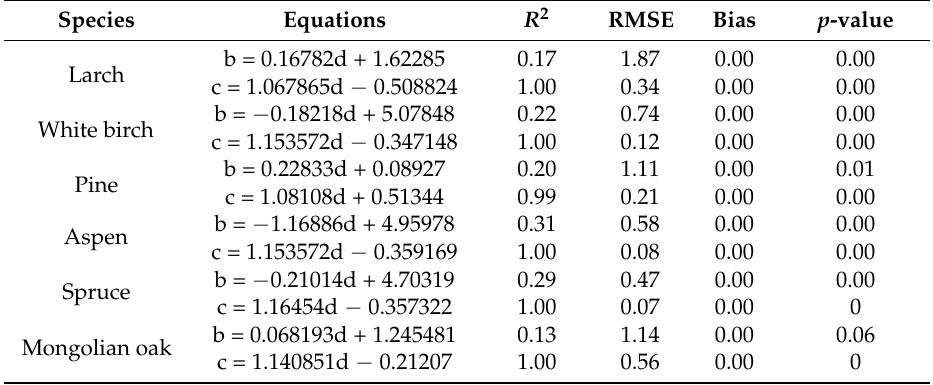
Table 3. Equations of shape parameter (b) and scale parameter (c) of Weibull diameter distribution depend on arithmetic mean DBH (d, unit: cm) for each species and accuracy assessment using leave-one-out cross validation